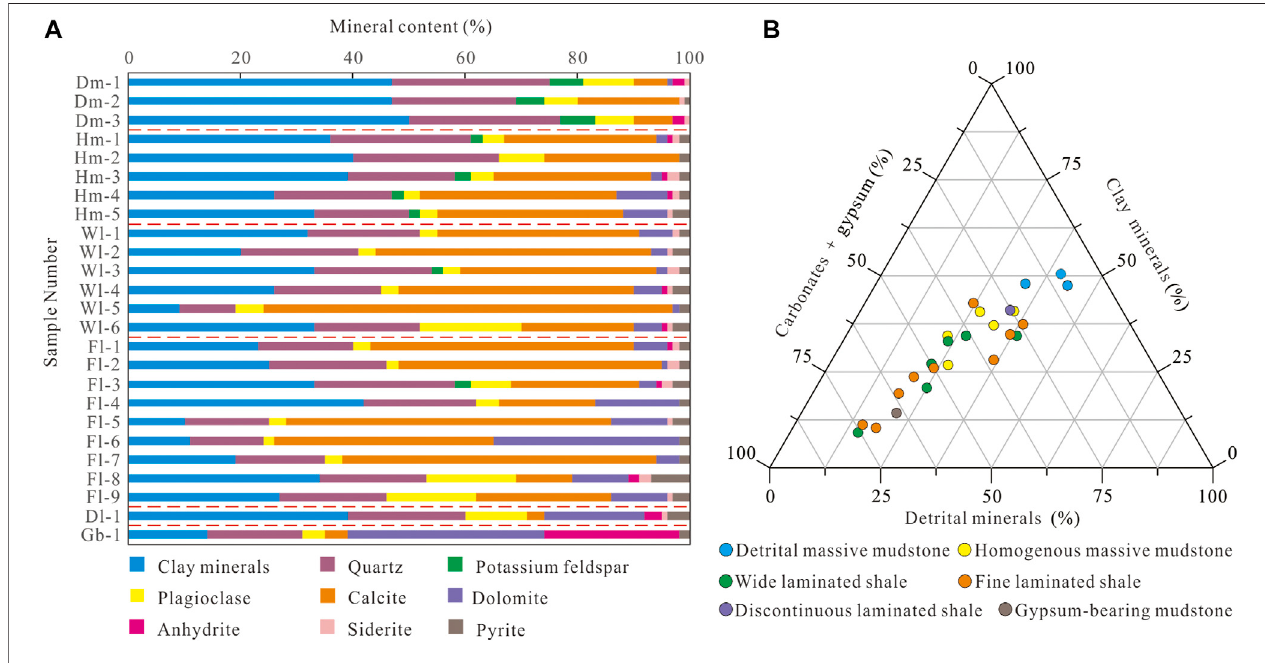
FIGURE 3 | Mineral compositions (A) and constituents (B) of the shale samples.